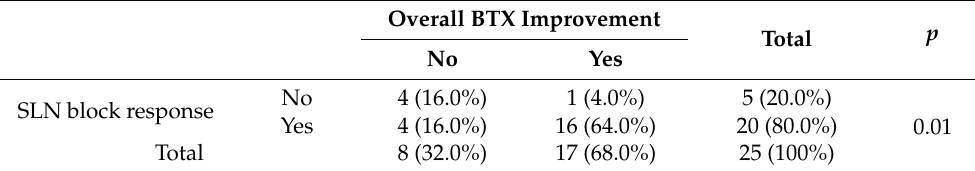
Table 10. Overall BTX improvement versus outcome of SLN